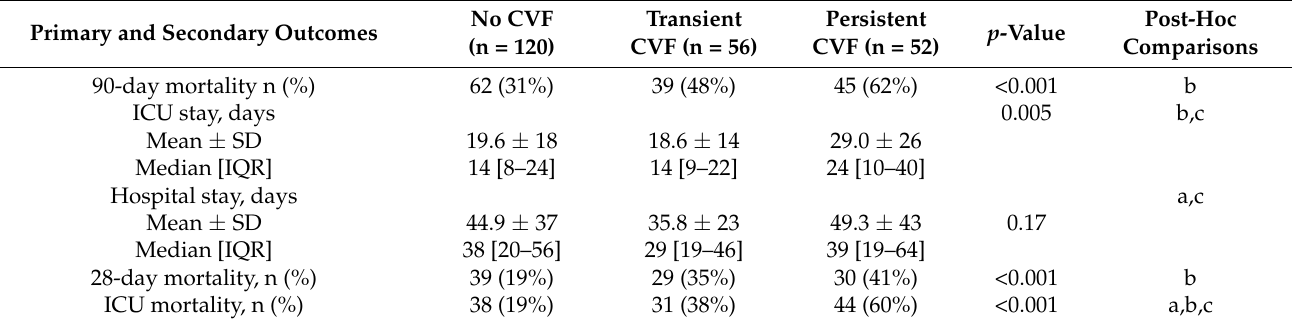
Table 7. Primary and secondary outcomes.